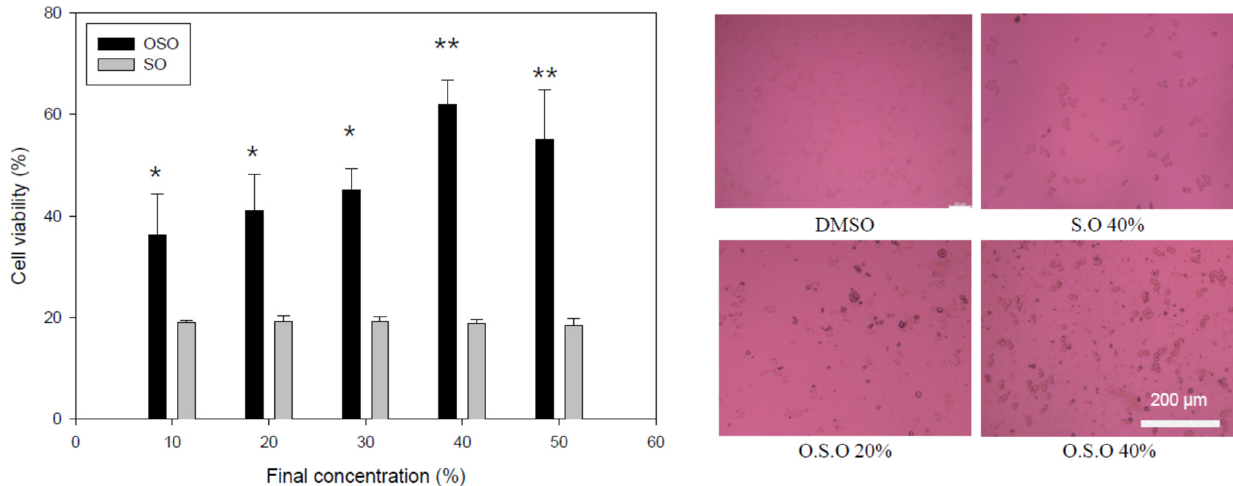
Figure 5. Paraoxonase (PON-1) activity of HDL 3 in the presence of OSO and SO. OSO, ozonated sunflower oil; SO, sunflower oil; * p < 0.05 compared to HDL 3 alone; ** p < 0.01 compared to HDL 3 alone.